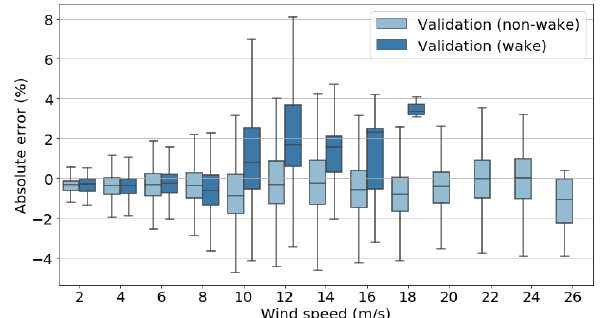
Figure 14. Box plot of error expressed as a percentage of the ab- solute maximal training DEL value (binned) of DEL for the vali- dation/training turbines plotted against wind speed under wake and under free-flow conditions.